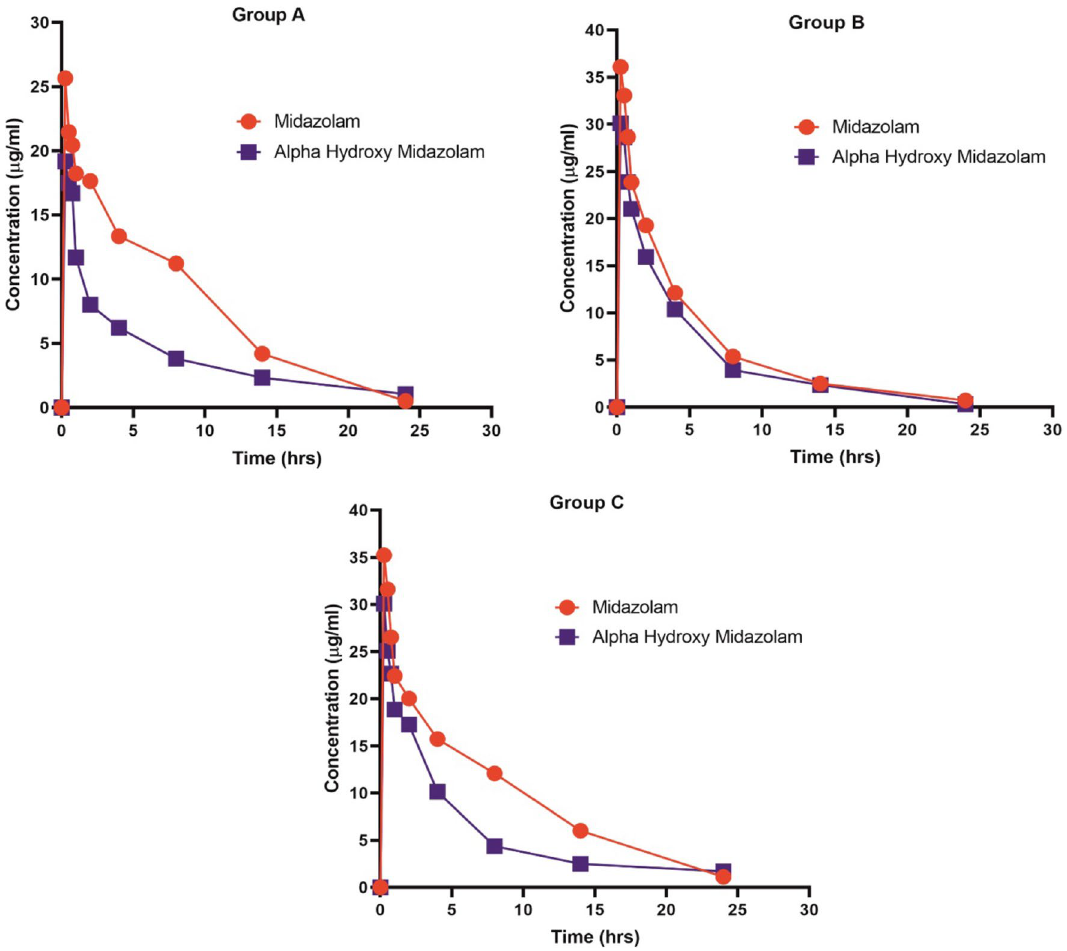
Figure 5. Mean plasma concentrations Vs Time curves of midazolam and alpha hydroxyl midazolam in Group A, Group B and Group